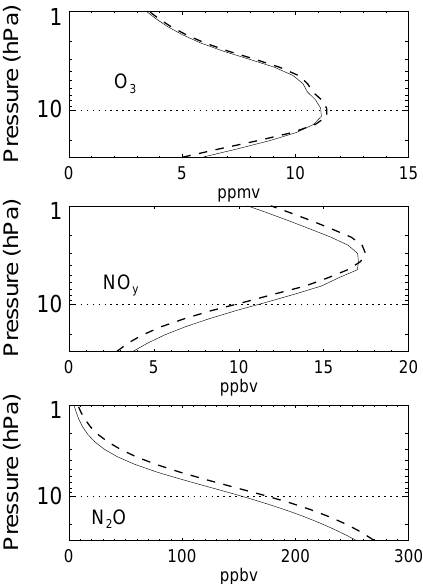
Figure 10. Annual average altitude profiles of O 3 , NO y , and N 2 O for the equator. The solid curve is a baseline run, while the dashed curve is a simulation which includes an additional 0.3Kday − 1 heat source in the lowermost stratosphere which acts to increase the trop- ical